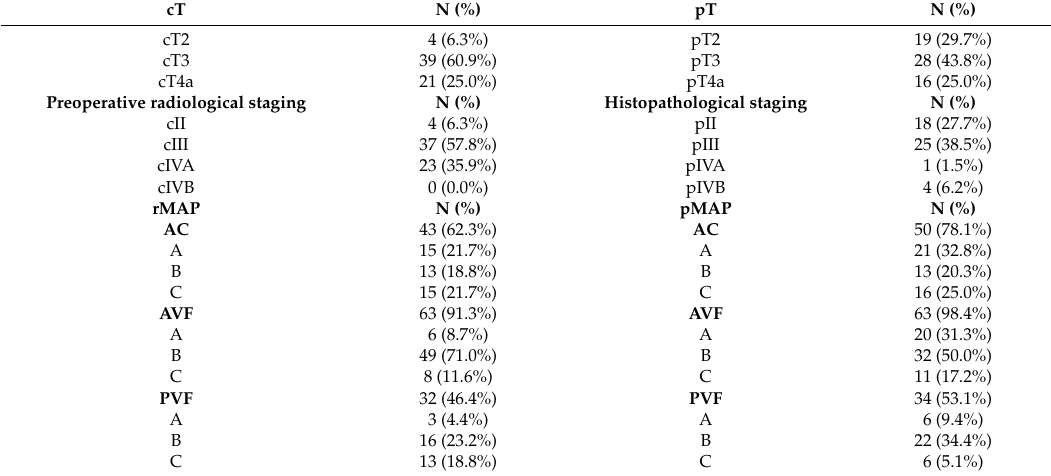
Table 1. Radiological and histopathological assessments of tumor extensions.